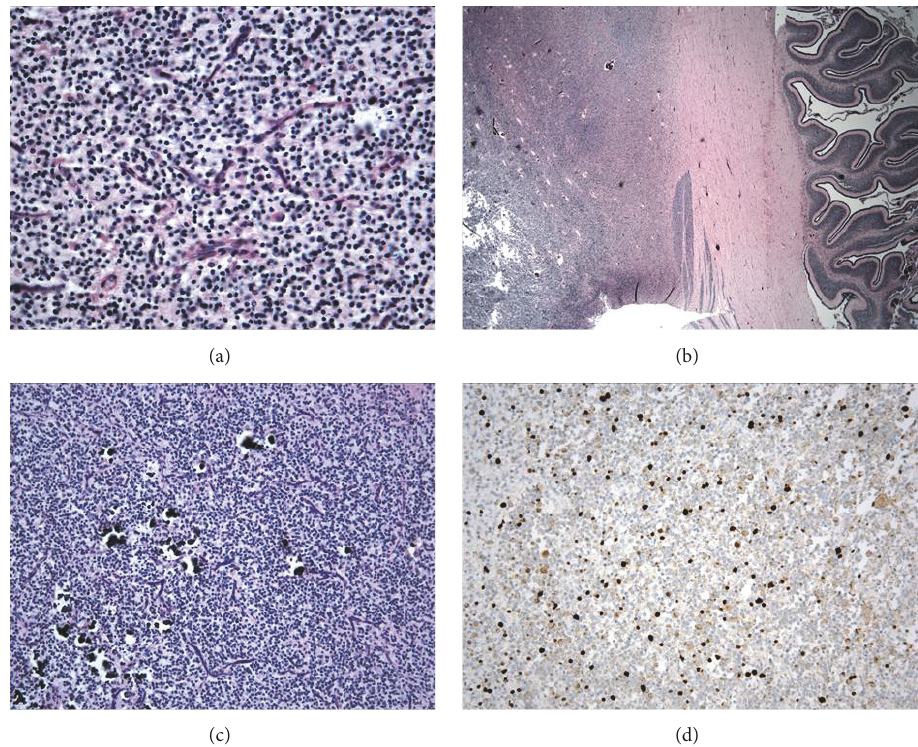
Figure 4: (a) The majority of the neoplasm showed cells with uniform, round nuclear morphology, diffuse chromatin, scant cytoplasm, and characteristic thin-walled chicken-wire vasculature. (b) Extensively infiltrative growth pattern of tumor permeating the pons, 4th ventricle, midbrain, medulla, cerebellar white matter, posterior thalamus, and occipital white matter. (c) Hypercellular areas with foci of calcifications. (d) Immunohistochemical staining demonstrated abundant labeling for